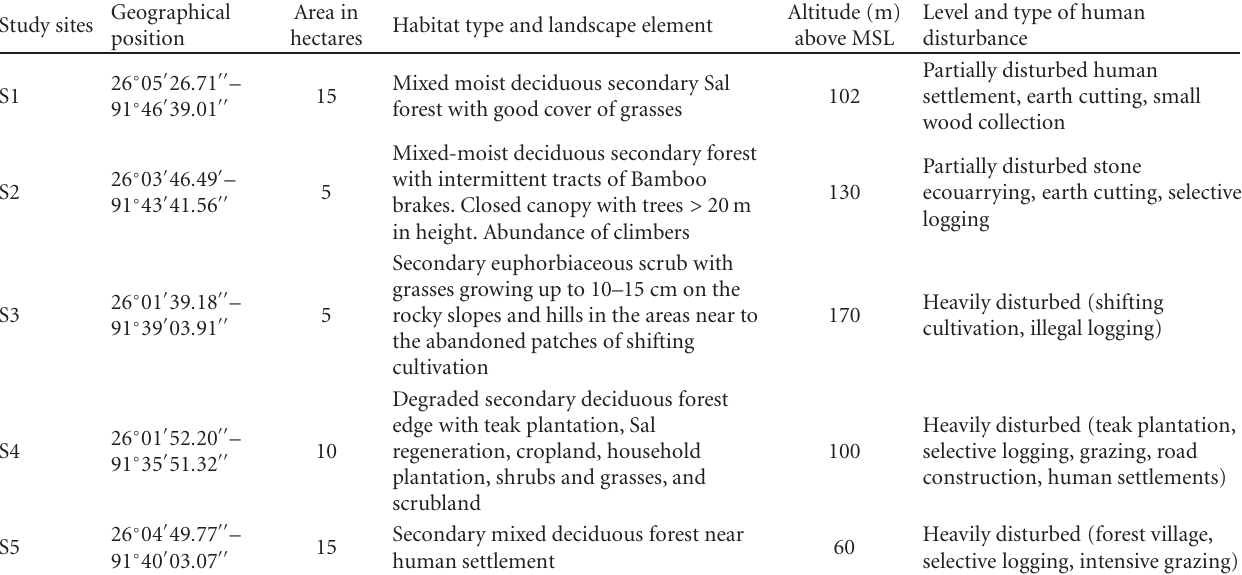
Table 1: Characteristics of the five study sites selected for butterfly